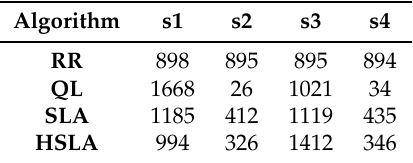
Table 9. Server (feeder link) selection count for Scenario-3 (GET).